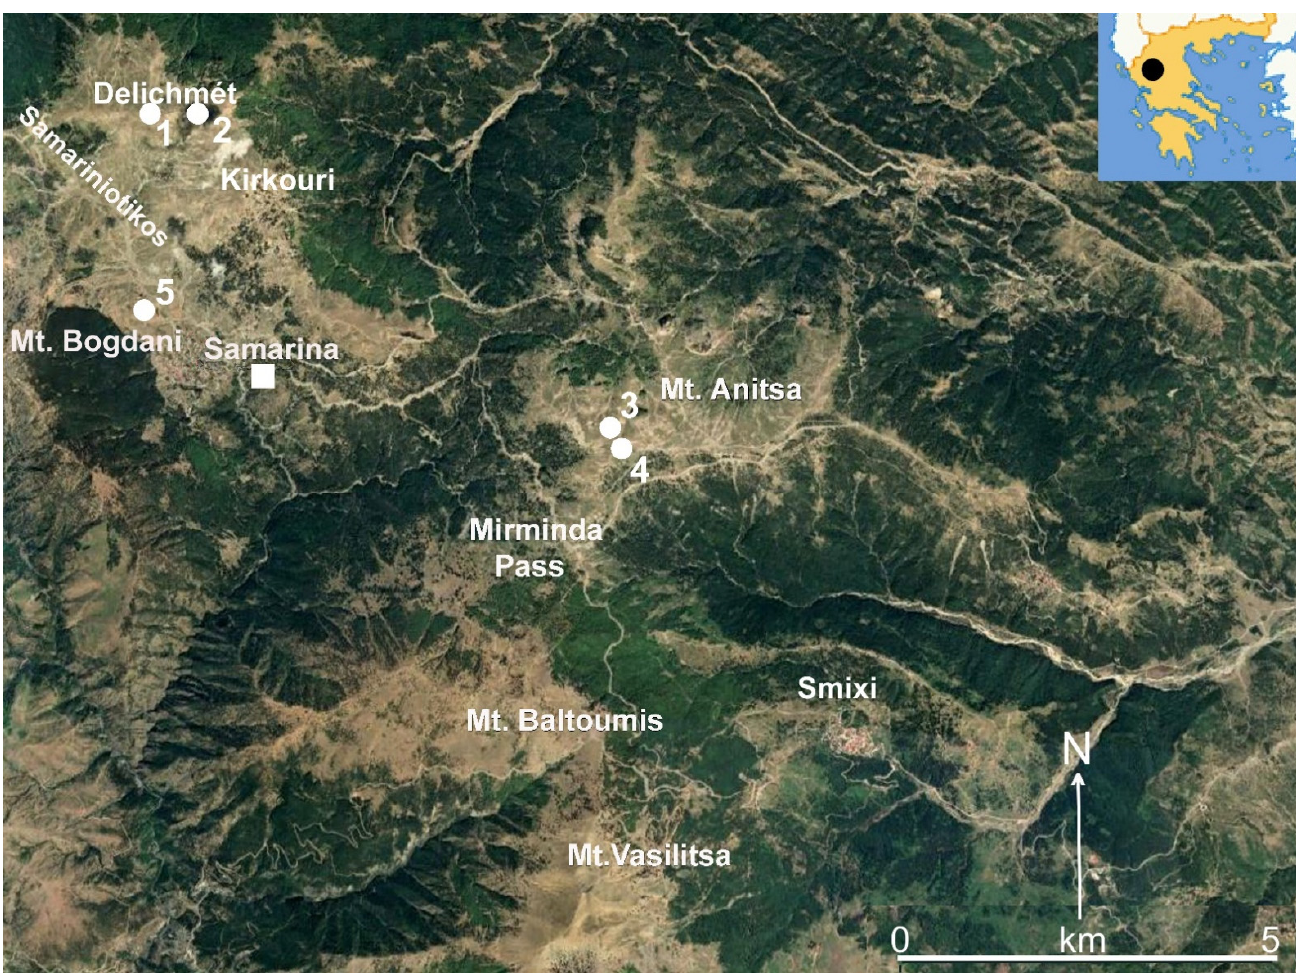
Figure 1. Map of the surveyed area showing the most important localities reported in the text, and the sites where test trenches were opened: Sam-8 (n. 1), Sam-5 (n. 2), Sam-29 (n. 3), Sam-23 (n. 4), and HC (n. 5) (drawing by P. Biagi).